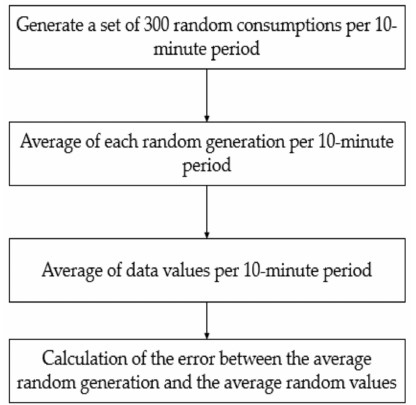
Figure 1. Flowchart of the sequence of statistical distributions evaluations.